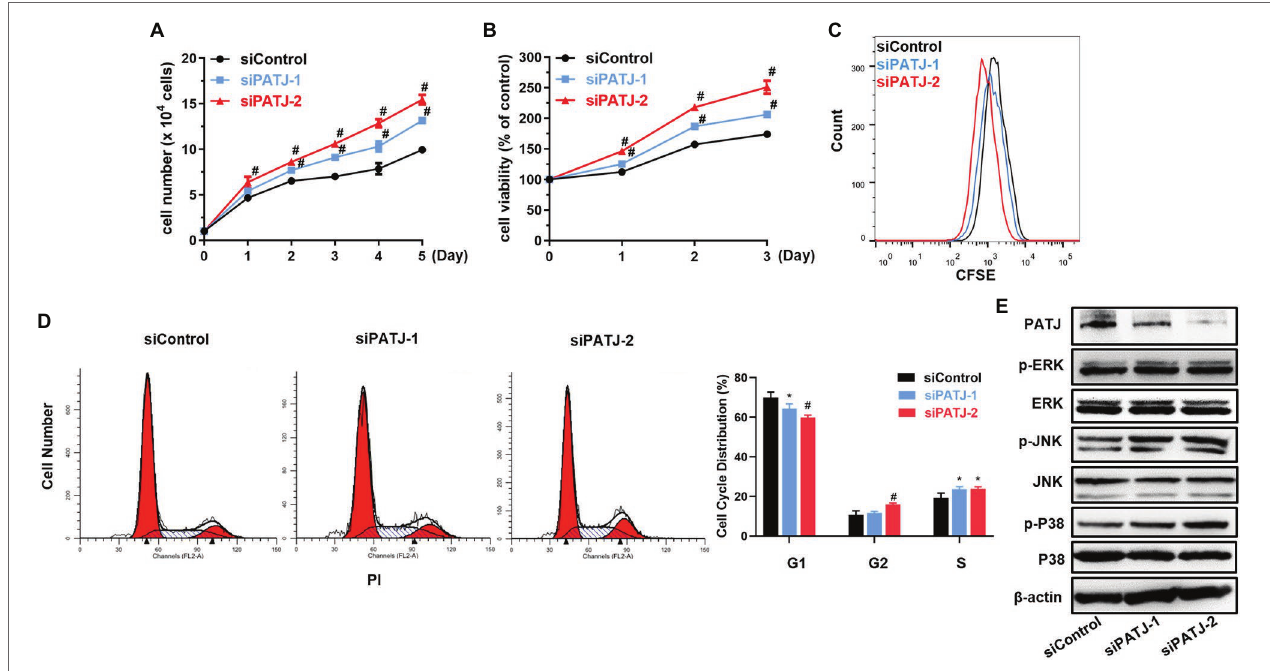
FIGURE 6 | Promotion of human renal tubular epithelial cell HKC proliferation after knockdown of PATJ protein. (A) Growth curves of siPATJ transfected HKCs. (B) Cell viability using the CCK-8 assay. The percentage of cell viability was calculated from the OD values of the test groups normalized to the control group. (C) The CFSE and FACS assay. (D) Flow cytometric analysis of cell cycle. (E) Western blot. * p < 0.05; and # p <